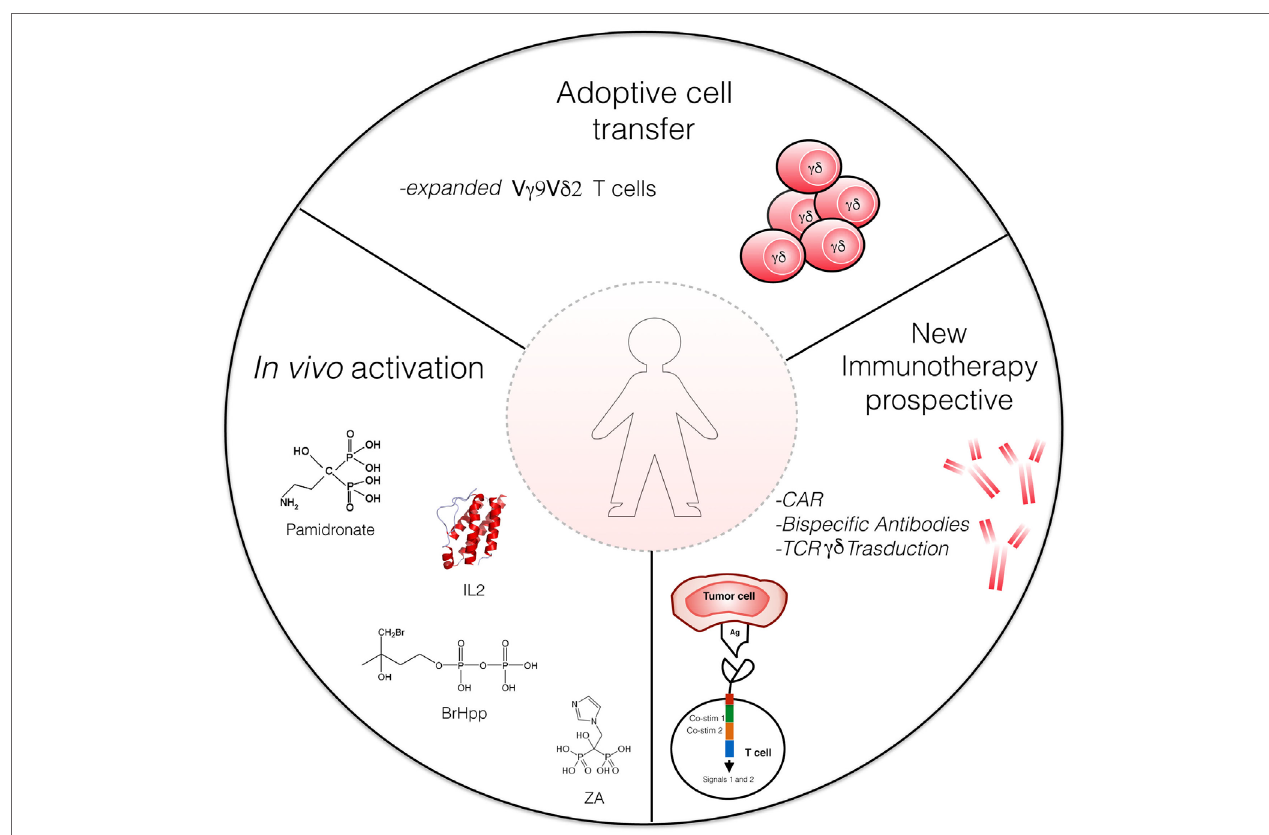
FiGURe 2 | Strategies for γδ T cell-based immunotherapy. Actual strategies include adaptive cell transfer of γδ T cells expanded in vitro with Zoledronate and interleukin (IL)-2, and in vivo activation of V γ 9V δ 2 T cells by phosphoantigens [e.g., bromohydrin pyrophosphate (BrHPP)] or aminobisphosphonates (Zoledronate) and low-dose IL-2. Novel γδ T cell-based therapeutic strategies involve bispecific antibodies and CAR-T cells. ZA, Zoledronate acid; CAR, chimeric antigen